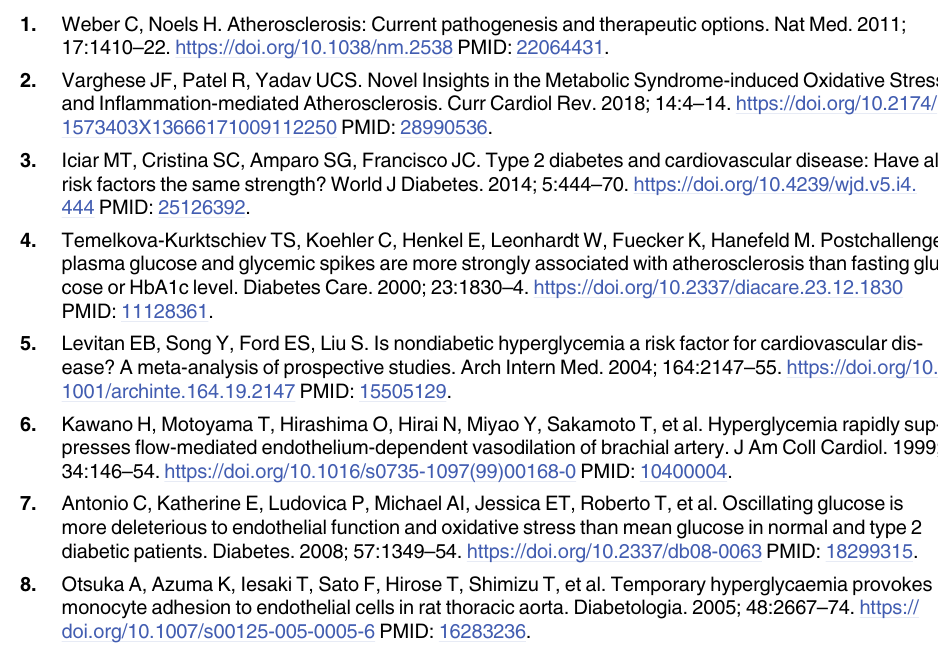
S1 Table. Assay IDs of the primers and probes used for the quantitative RT-PCR analysis.